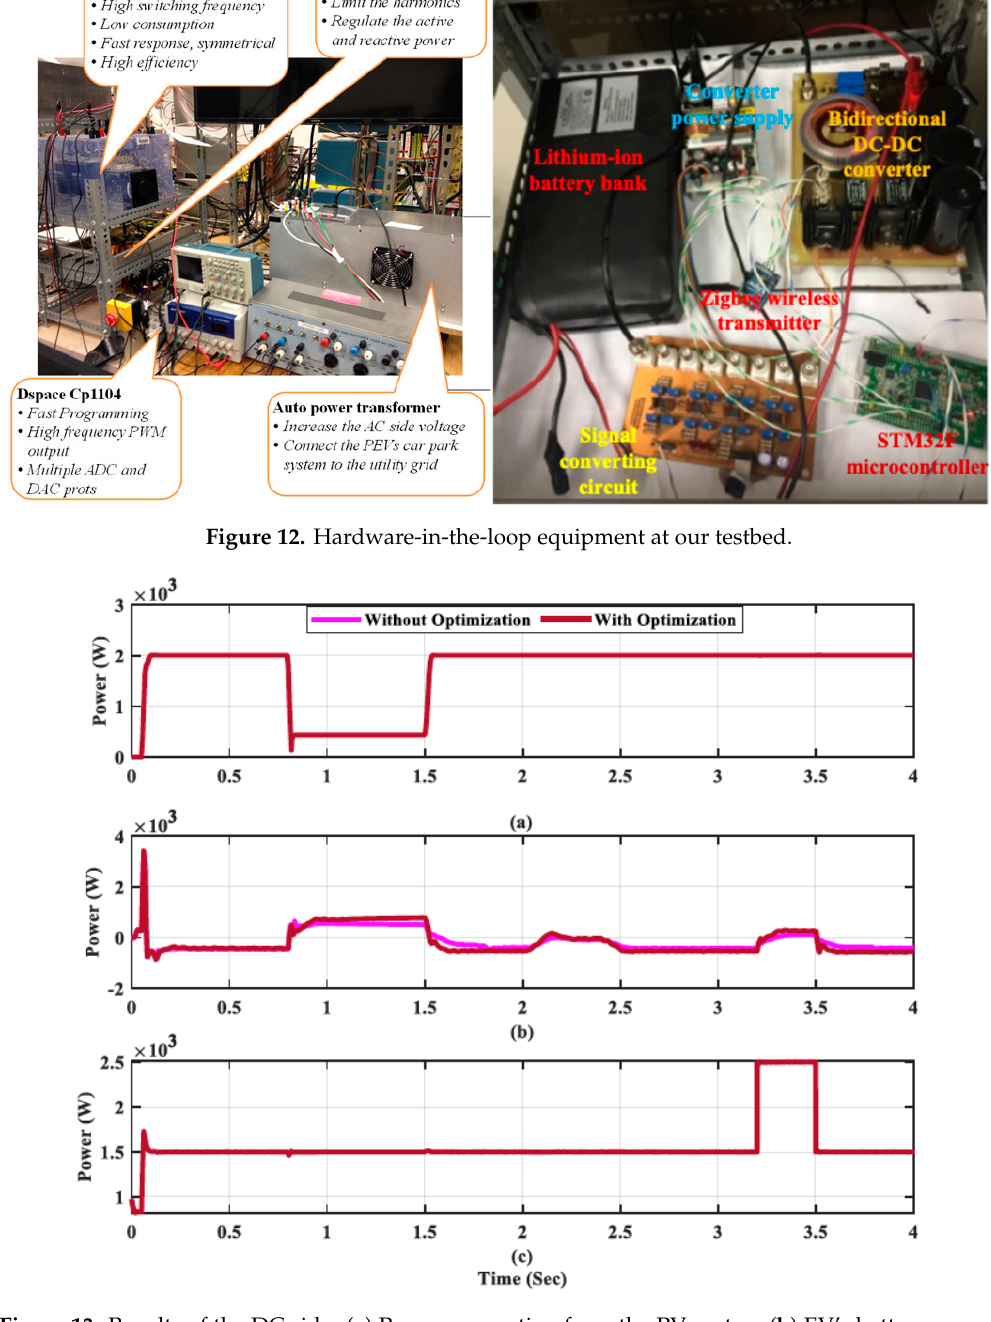
Figure 13. Results of the DC side: ( a ) Power generation from the PV system ( b ) EV’s battery power ( c ) Load power.